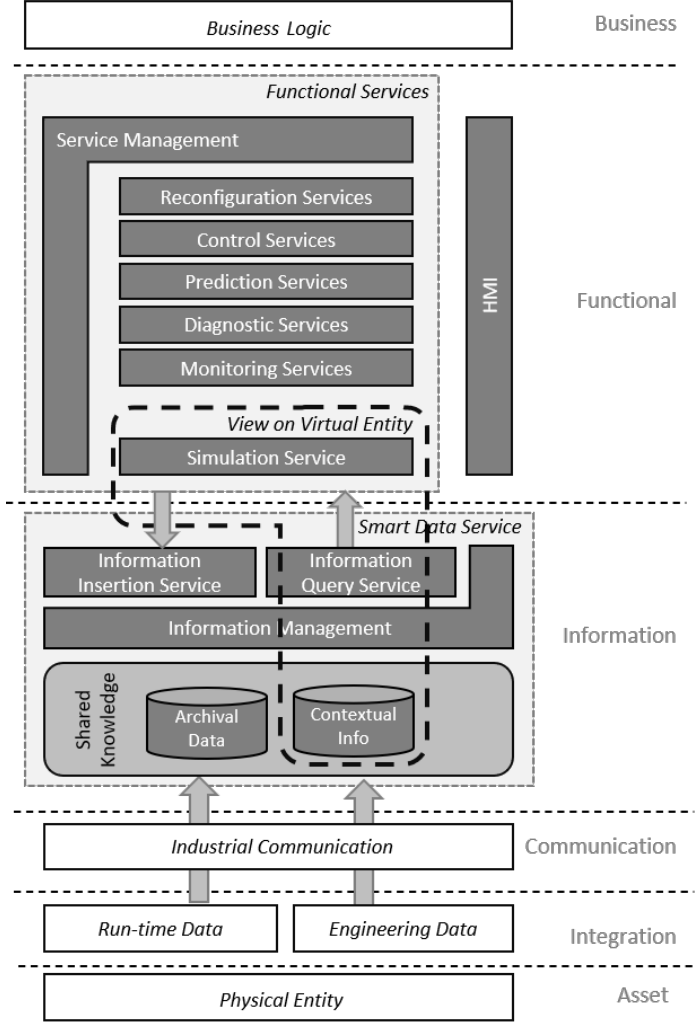
Figure 2. Generic Digital Twin Architecture (GDTA)